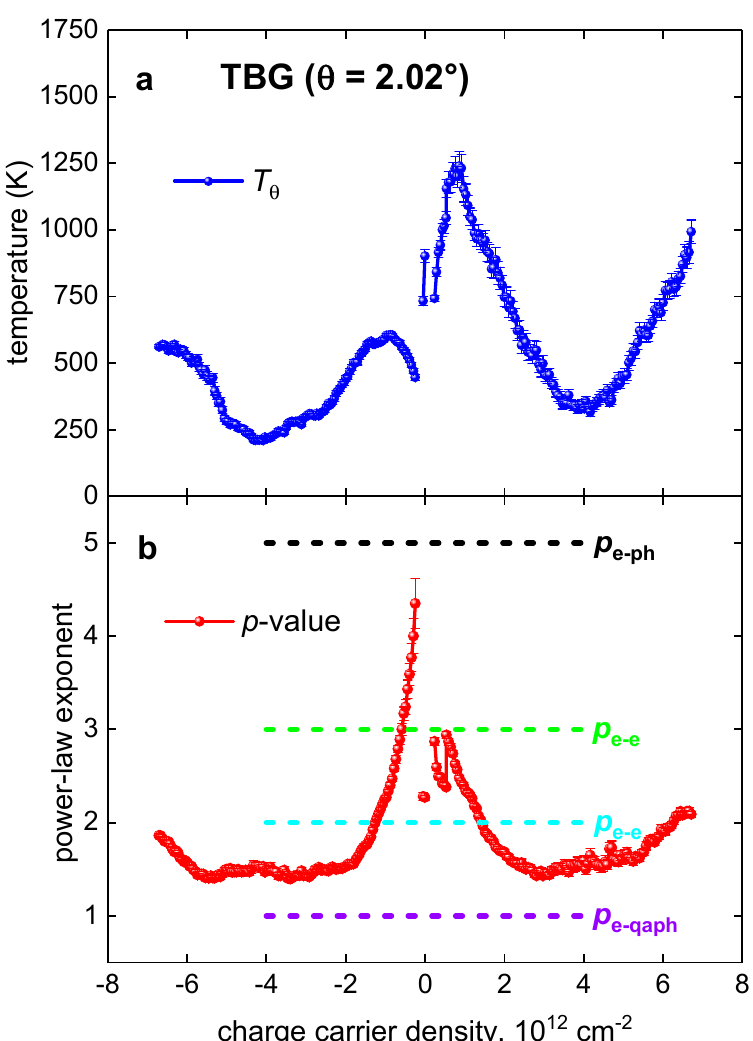
Figure 7. Summarized results for TBG superlattice with θ = 2.02°. ( a ) Deduced Debye temperature; ( b ) deduced p -value. Characteristic values for the quasielastic electron–acoustic phonon interaction ( p e-qaph = 1), the electron–electron interaction ( p e-e = 2), the electron–magnon interaction ( p e-m = 3), and the electron–phonon interaction ( p e-ph = 5) are shown.